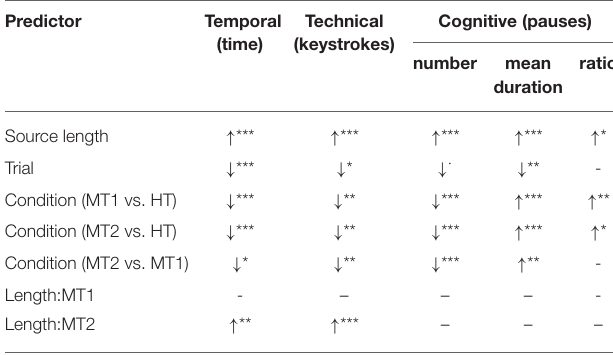
TABLE 2 | Significance of predictors in the mixed models built for each effort